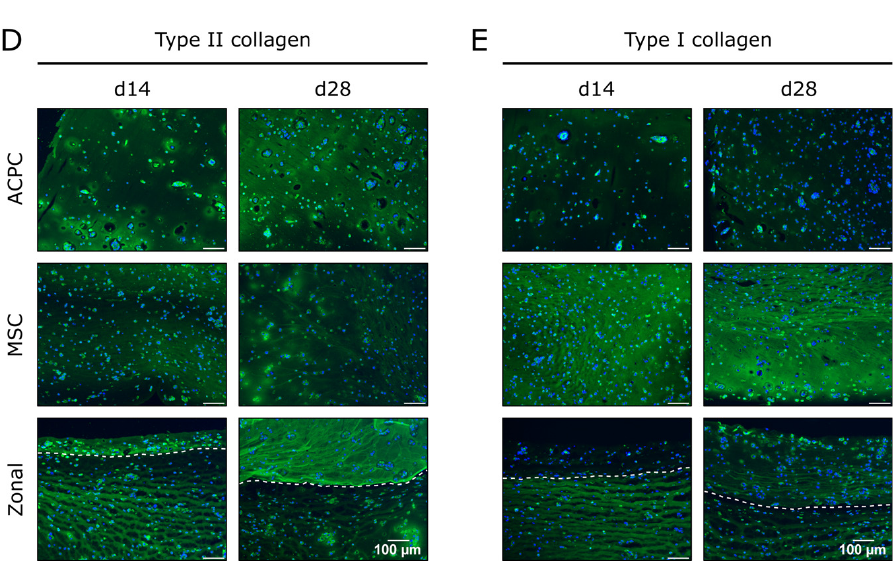
Figure 4. Collagen production in ACPC, MSC, and zonal constructs under hypoxic conditions. Biochemical, histological, and immunohistochemical analysis of collagen in agarose hydrogel constructs, seeded with 20.0 × 10 6 cells mL − 1 , after 1, 14, and 28 days of chondrogenic di ff erentiation under hypoxic conditions. ACPCs and MSCs were either cultured alone or in zonally layered co-culture constructs. ( A ) Production of total collagen (collagen / construct) and ( B ) collagen normalized to DNA (collagen / DNA). Data are presented as means ± standard deviations ( n = 3 biological replicates). Note: (*) indicates statistically significant di ff erences between a d14 or d28 value and the corresponding d1 value of the same group ( p < 0.05); ( ∆ ) indicates statistically significant di ff erences between groups, or within a group between time points ( p < 0.05). ( C ) Histological picrosirius red staining for visualization of produced collagen under hypoxic conditions. Immunohistochemical staining for ( D ) type II collagen and ( E ) type I collagen under hypoxic conditions. In zonal constructs, the upper layer contained ACPCs and the lower layer contained MSCs (indicated by the dashed